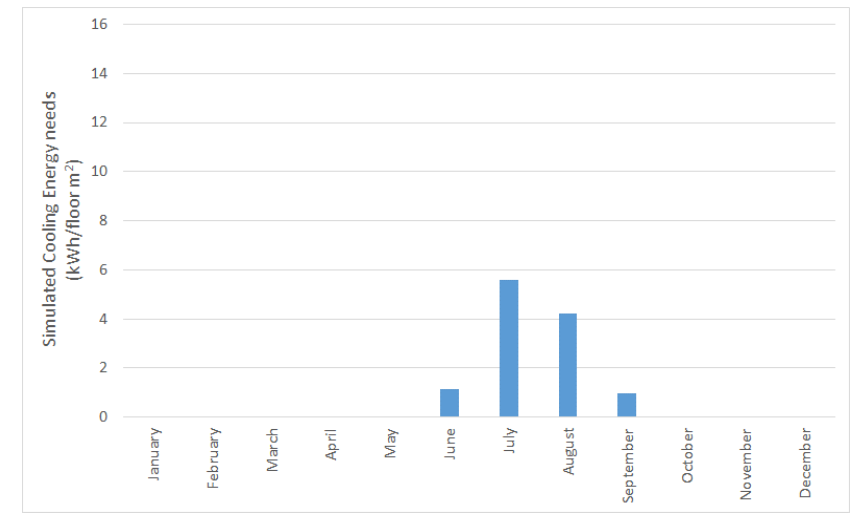
Figure 7. Simulated cooling demand for the building under study.